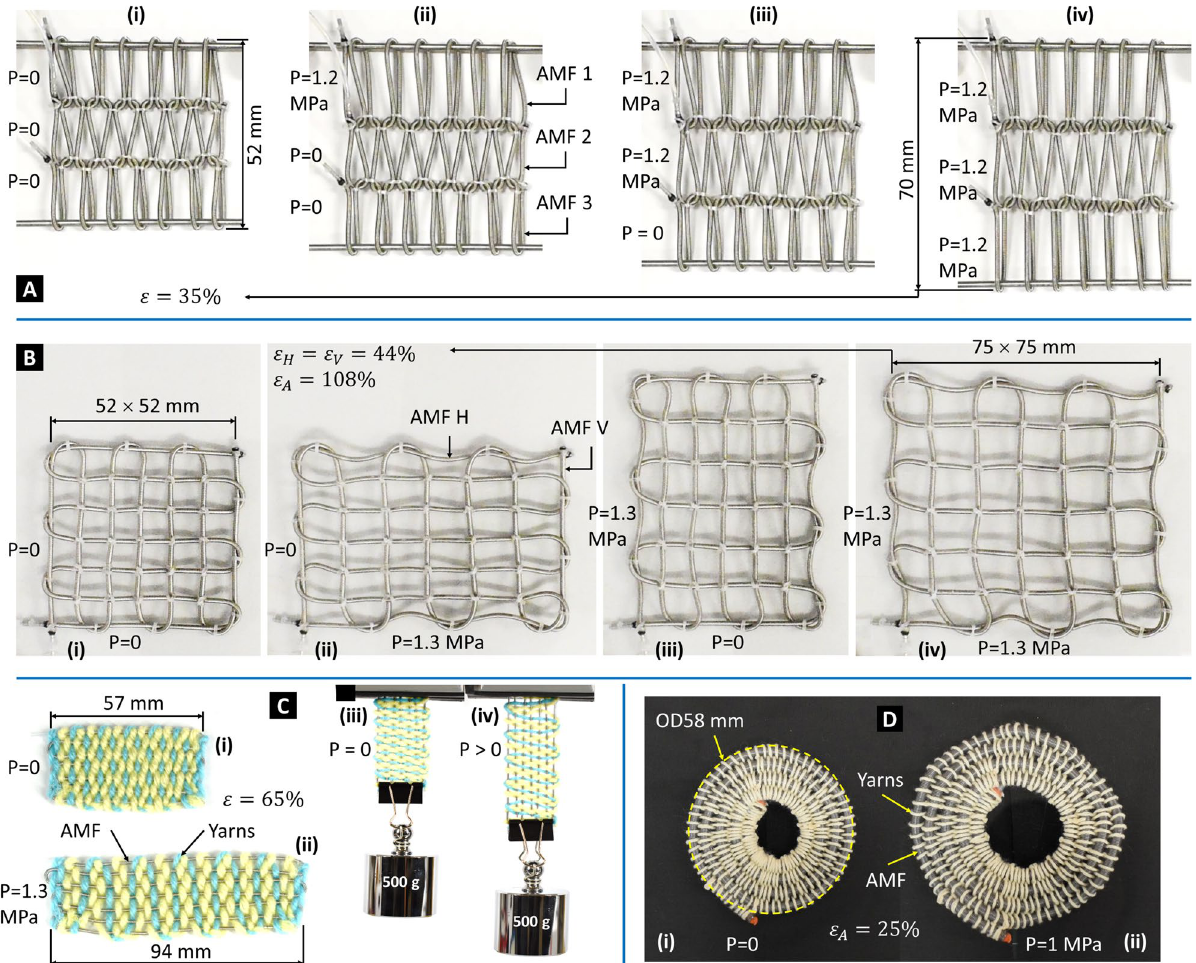
Figure 2. Different prototypes of smart textiles are achieved by varying AMF configurations. ( A ) Knitting sheet made from three AMFs. ( B ) Bidirectional weaving sheet made from two AMFs. ( C ) A unidirectional weaving sheet made from one AMF and acrylic yarns could lift a 500 g load, which is 192 times heavier than its mass (2.6 g). ( D ) Radial expansion structure made from a single AMF and cotton yarns as radial constraints. Detailed specifications can be found in the “Methods”